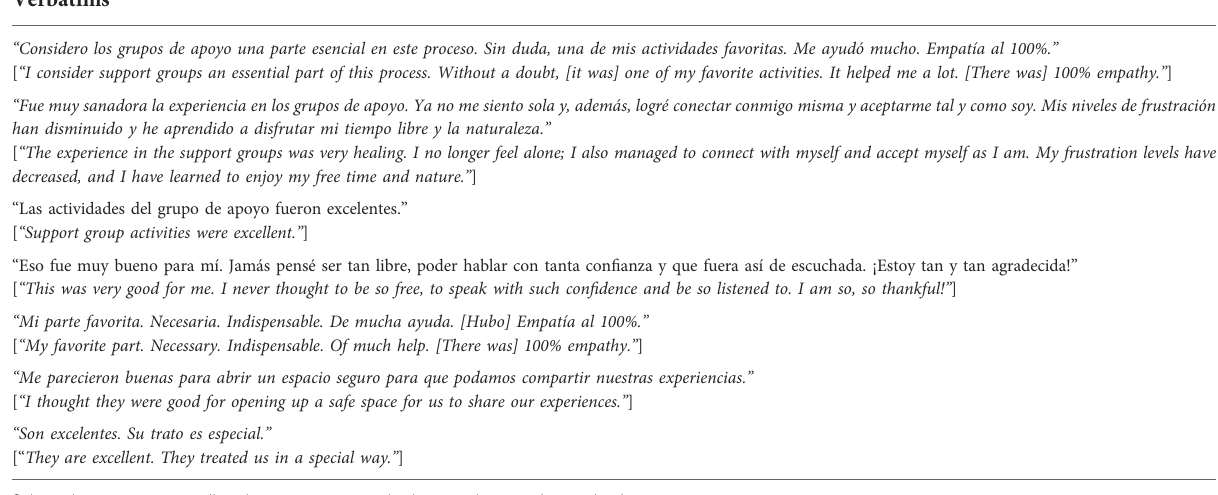
TABLE 5 Feasibility of the EE intervention: analysis of open-ended question answers in the fi nal evaluation survey. Verbatims